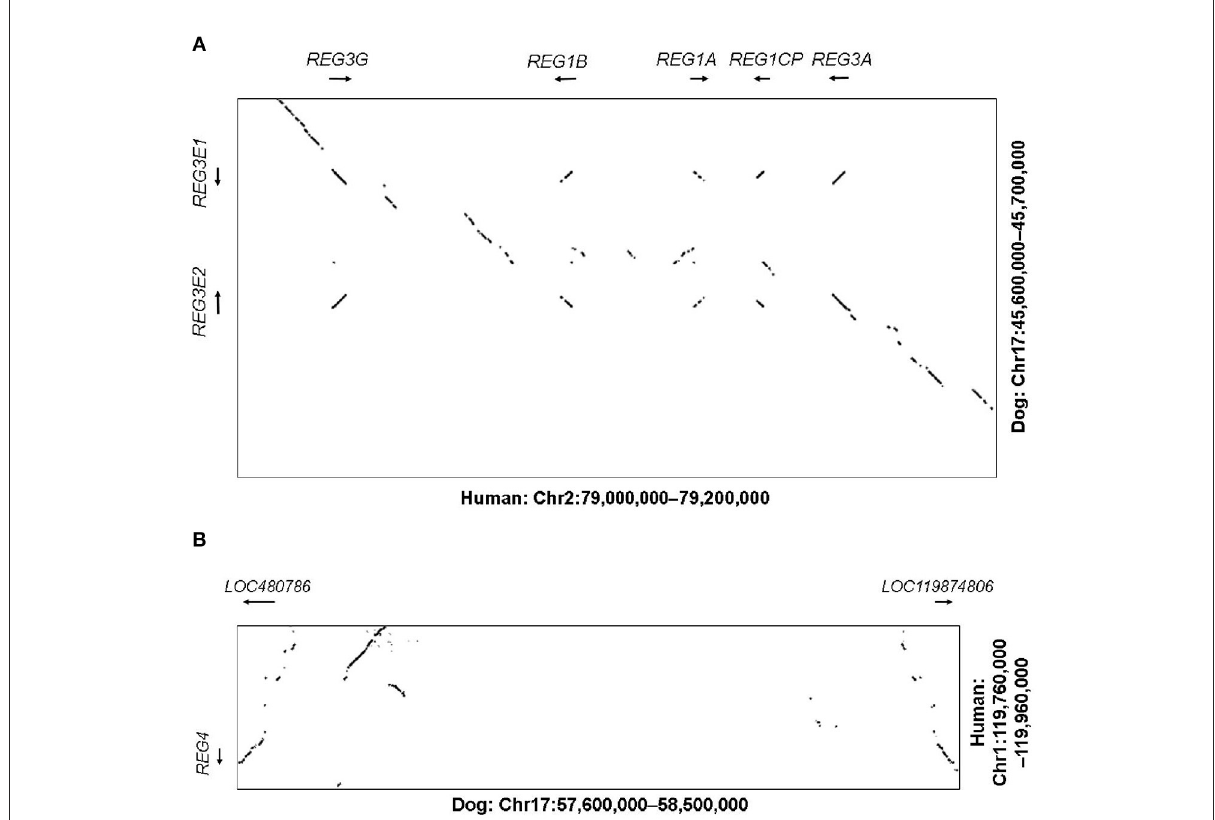
FIGURE1 (A) Dot plot illustrating the comparative analysis of the REG3 genomic region. The human region containing the REG1 and REG3 subfamilies (Chr2:79.0-79.2M) is shown on the X-axis against the corresponding canine region (Chr17:45.6–45.7M) on the Y-axis. Sequences of high similarity between both species are depicted as diagonal lines at the corresponding positions, representing potential homologous genes, with the direction of the line reflecting the direction of the genomic sequences (forward vs. reverse strand). Whilst the human region contains two REG1 and two REG3 genes plus a pseudogene, the canine region only contains two REG3 genes, namely REG3E1 and REG3E2 . (B) Dot plot illustrating the comparative analysis of the REG4 genomic region. The human region containing REG4 (Chr1:119.76–119.96M) on the Y-axis is shown against the corresponding canine region (Chr17:57.6–58.5M) on the X-axis. Whilst in people, only one REG4 gene is present, two canine candidate REG4 genes were identified ( LOC480786 and LOC119874806